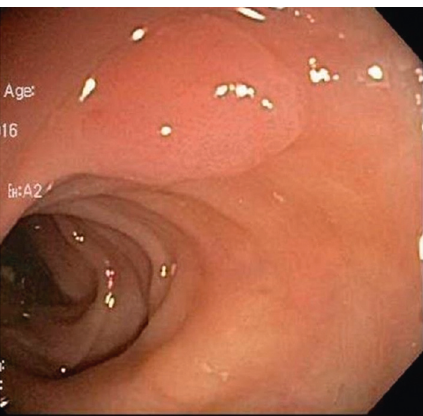
Figure 1: Colonoscopy showing a 10mm sessile sigmoid colon